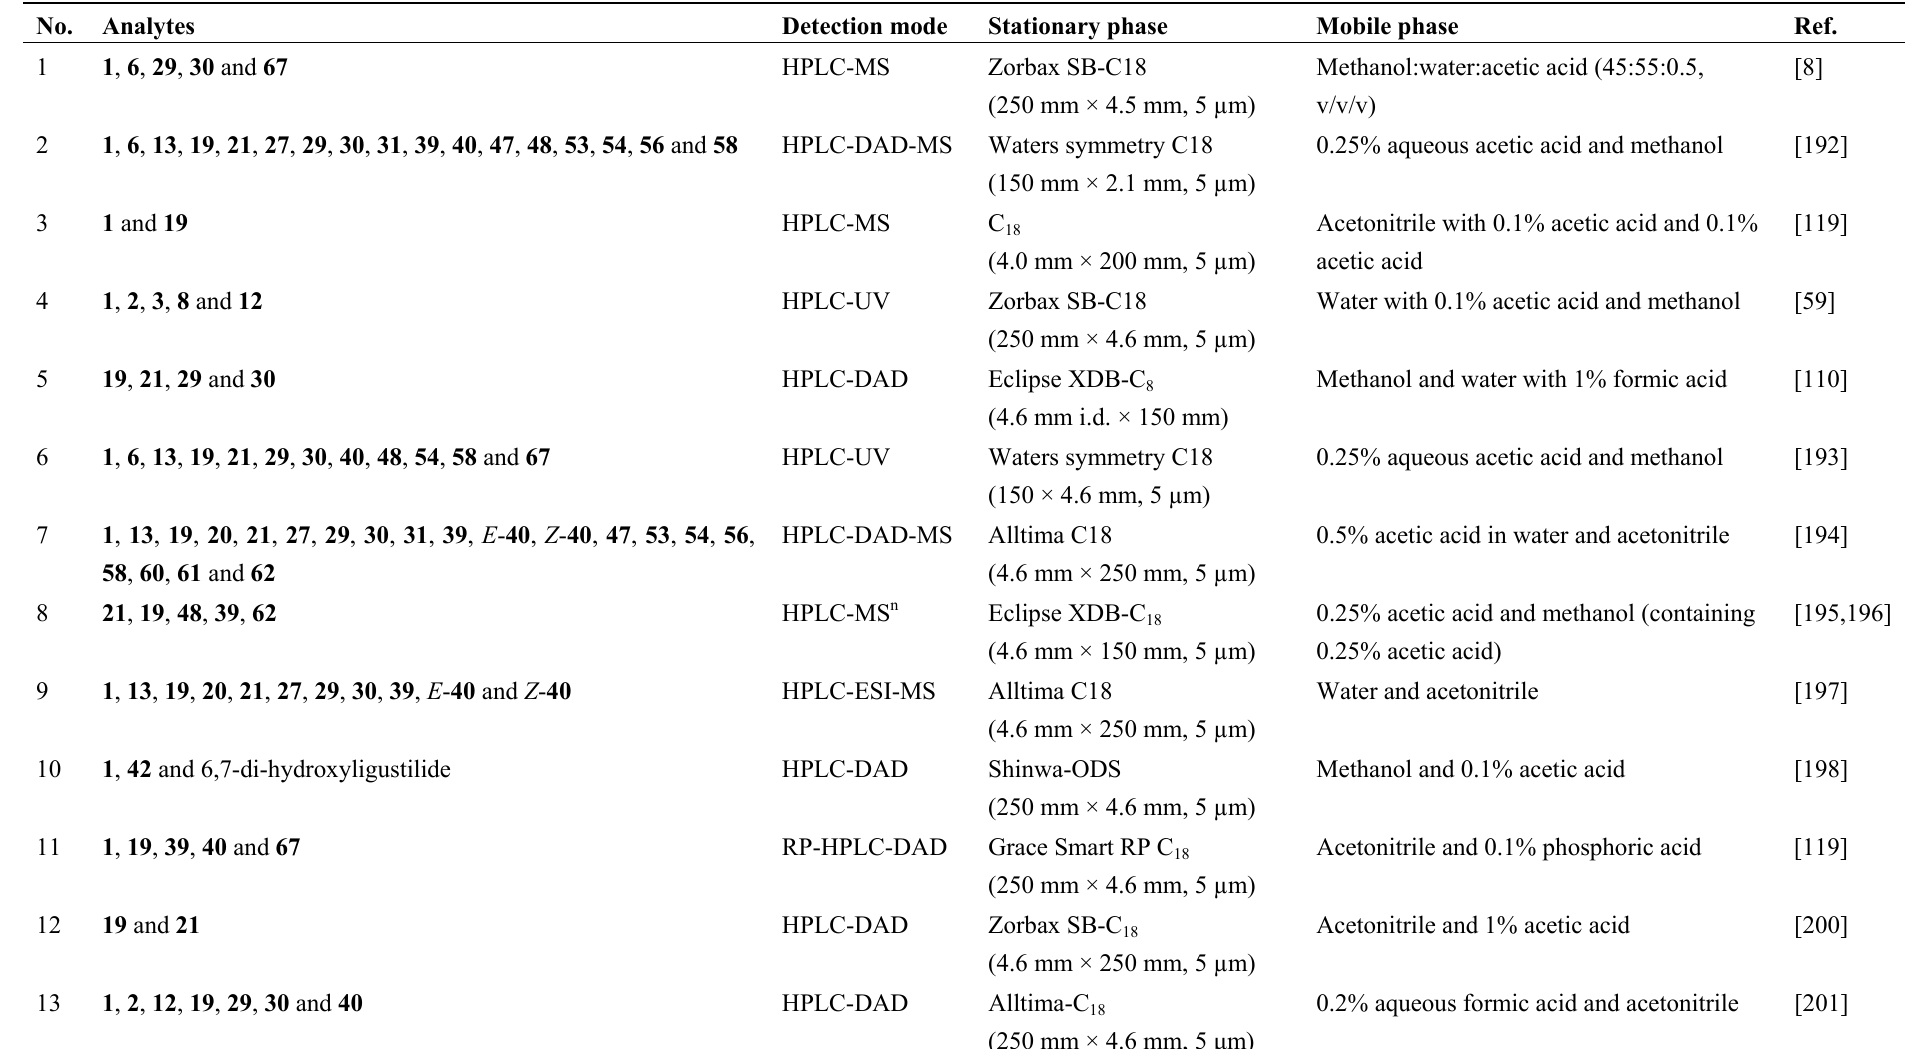
Table 6. HPLC methods developed for simultaneous chemical analysis of